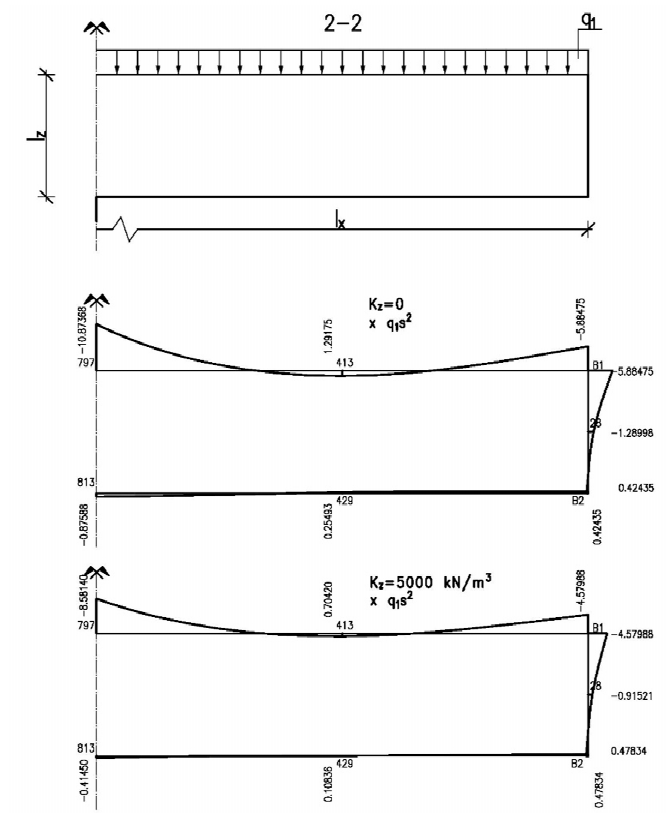
Figure 7. Charts of bending moments due to the uniform load of the top plate without taking into account the effect of an elastic substrate and for the Poisson’s ratio ν = 0 and taking into account the effect of an elastic substrate K = 5000 kN/m 3 and for the Poisson’s ratio ν = 0 in cross section 1– 1 (Figure 4).